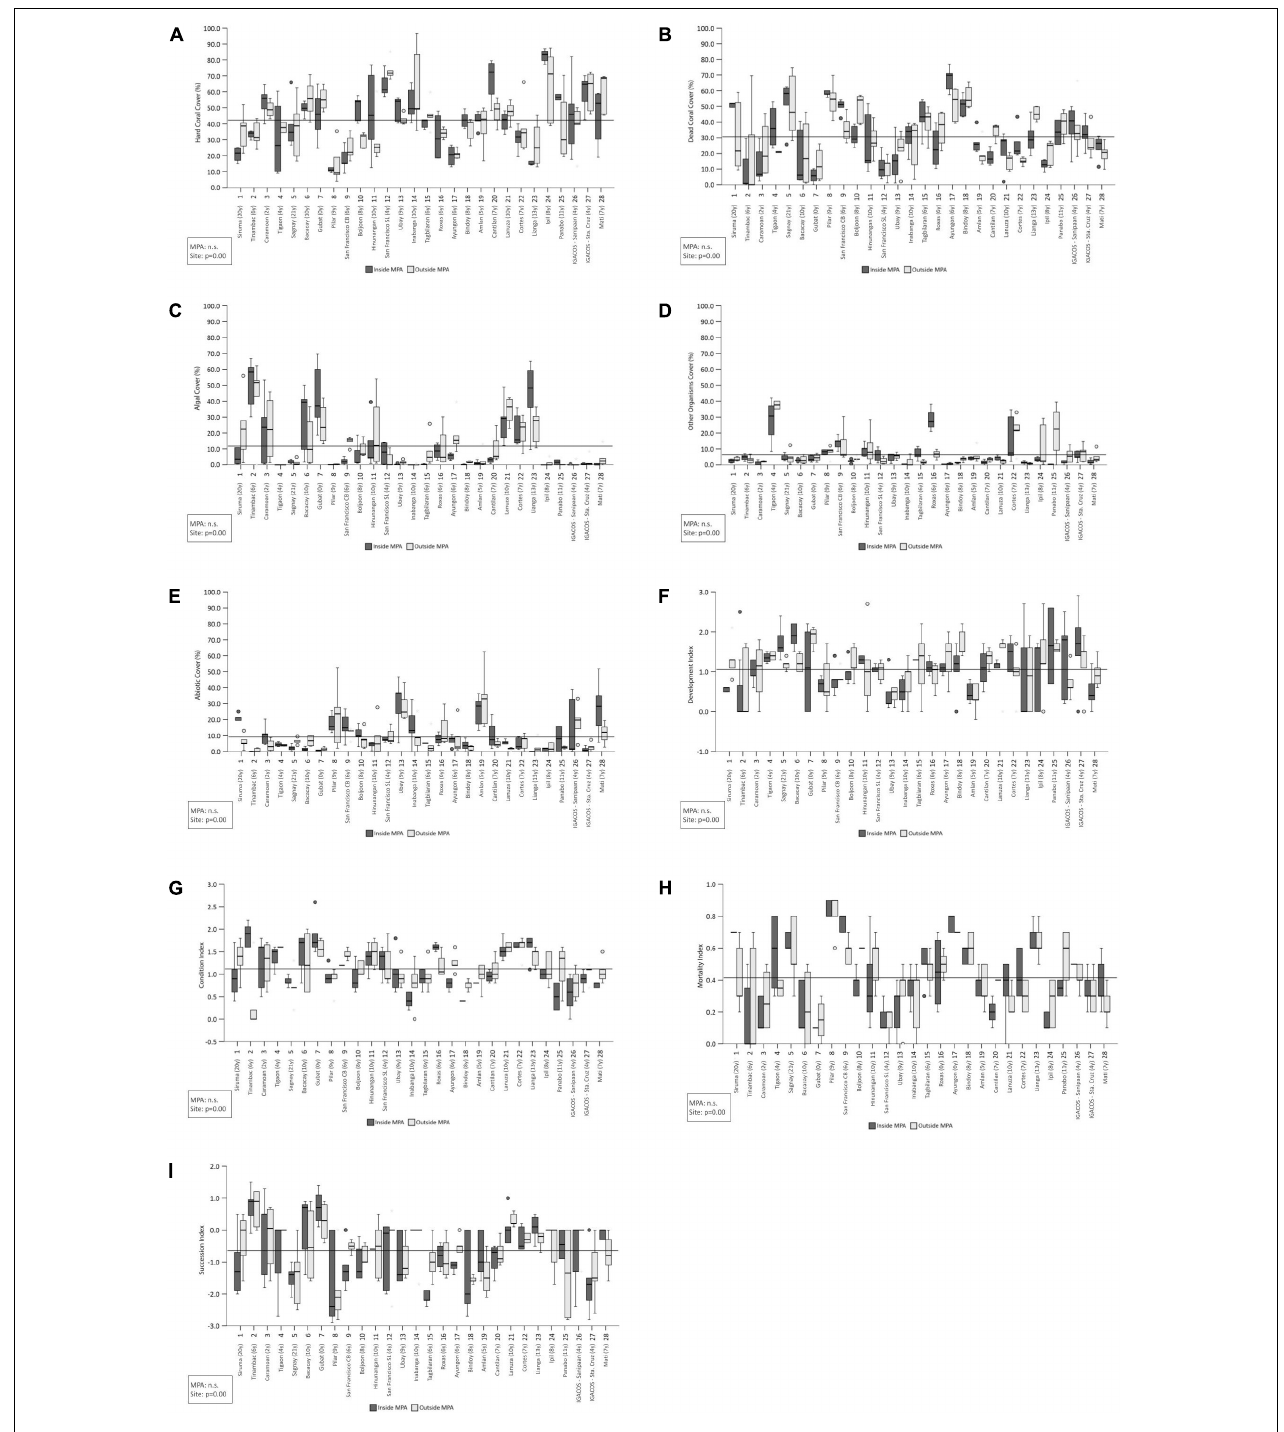
FIGURE 3 | Variation of benthic condition across MPA locations in terms of (A) hard coral cover, (B) dead coral cover, (C) algal cover, (D) cover of other benthic organisms, (E) abiotic cover, (F) development index, (G) condition index, (H) mortality index, and (I) succession by algae index.